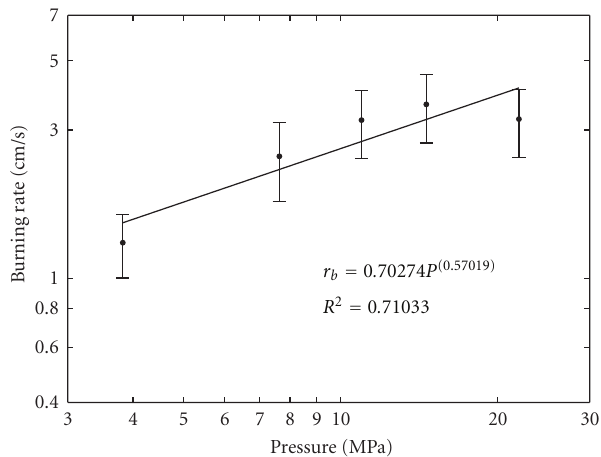
Figure 3: Burning rate data of ALICE propellant mixed with the Resodyn